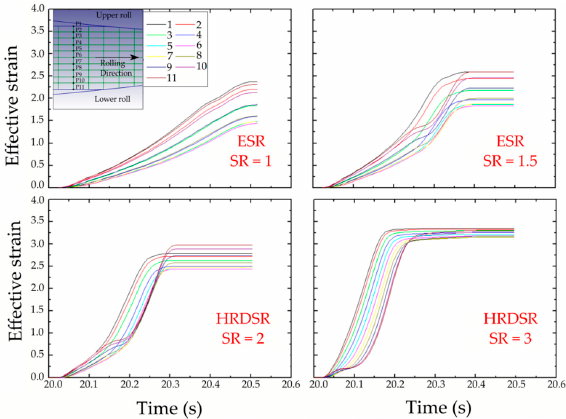
Figure 8. ( a ) The analyzed points in the enmeshed domain of simulation and ( b ) the accumulated shear strain along the thickness of the sheet using finite element simulation for HRDSR with SR = 3 for a thickness reduction of 70% by a single pass [46]. Reproduced with permission from Kim et al., Mater. Sci. Eng. A ; published by Elsevier, 2013.